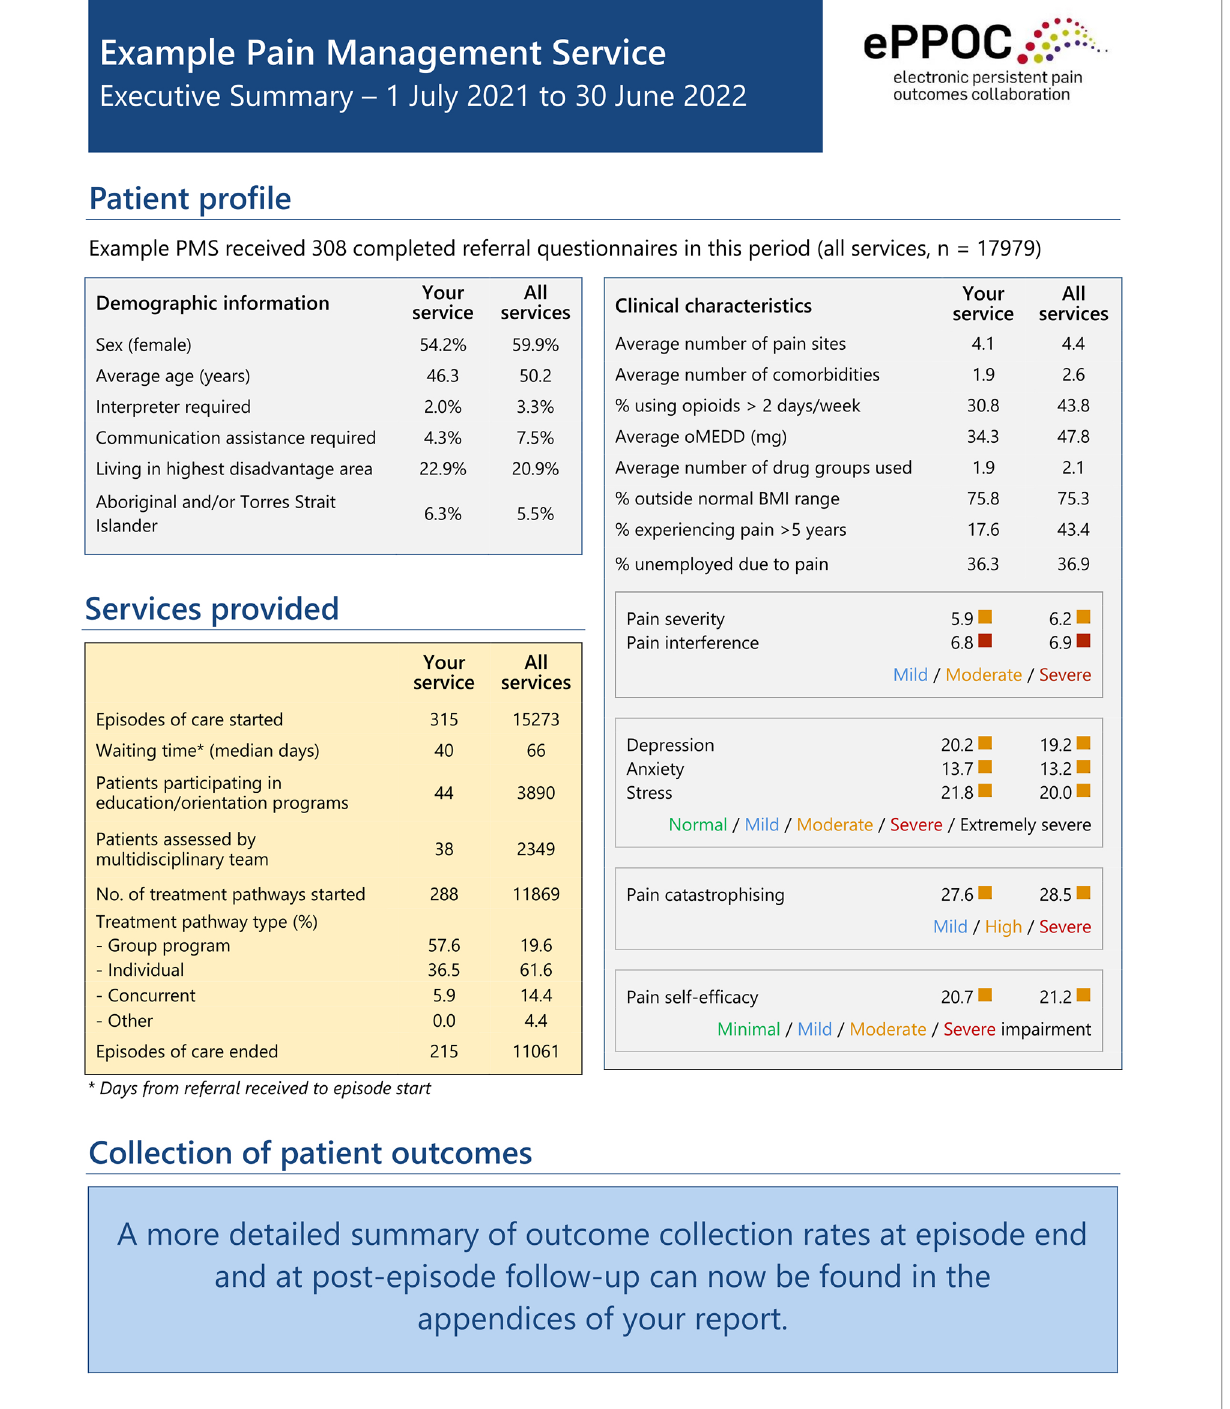
FIGURE 1 Example of one part of standardized